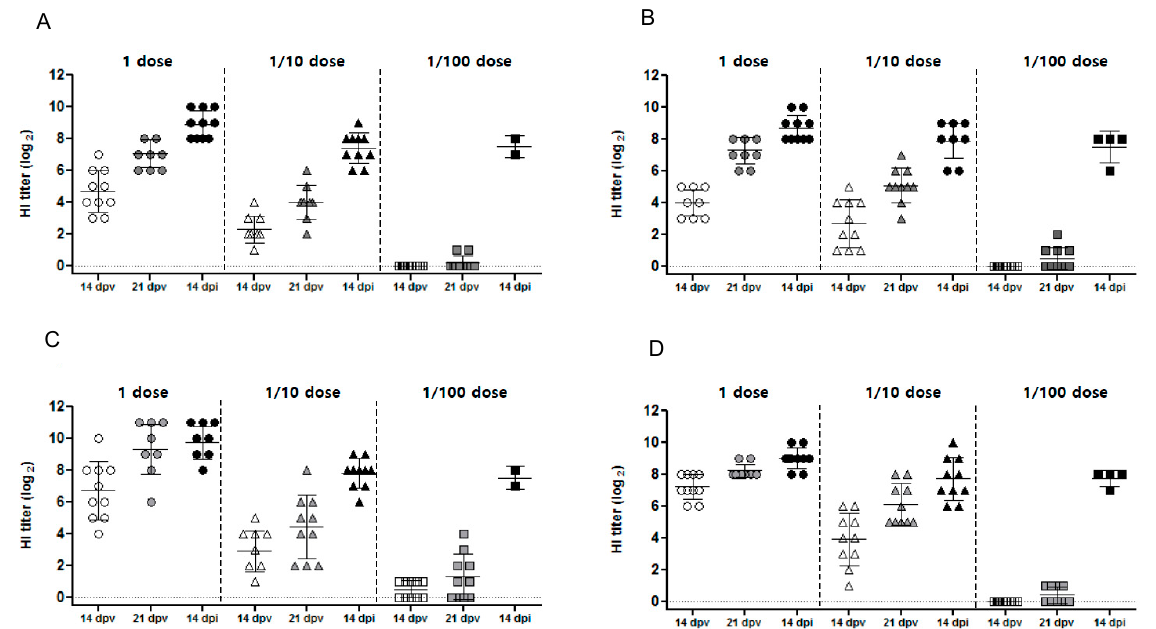
Figure 3. Hemagglutination inhibition (HI) assay titers in chickens vaccinated at different times with a full dose, a 1/10 dose, or a 1/100 dose of each candidate vaccine. HI titers were assessed at 14 days post-vaccination (dpv), at 21 dpv, and at 14 days post-infection. ( A ) HI titer of rgCA2/2.3.2.1d against challenge virus antigen; ( B ) HI titer of rgES3/2.3.4.4h against challenge virus antigen; ( C ) HI titer of rgCA2/2.3.2.1d against vaccine strain antigen; and ( D ) HI titer of rgES3/2.3.4.4h against vaccine strain antigen. Individual data points are shown, along with the mean and standard error.